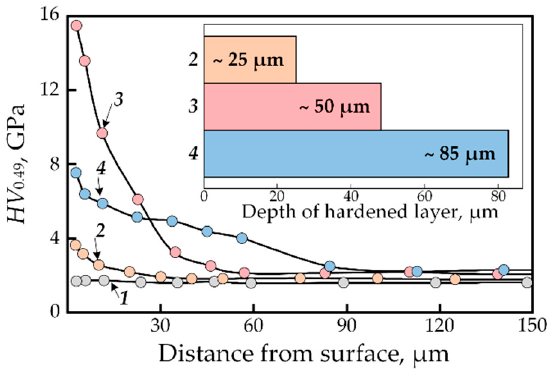
Figure 12. Hardness distribution in the surface layer of titanium Grade 2 in initial state (1), after nitriding (2, 3), and after boriding (4).